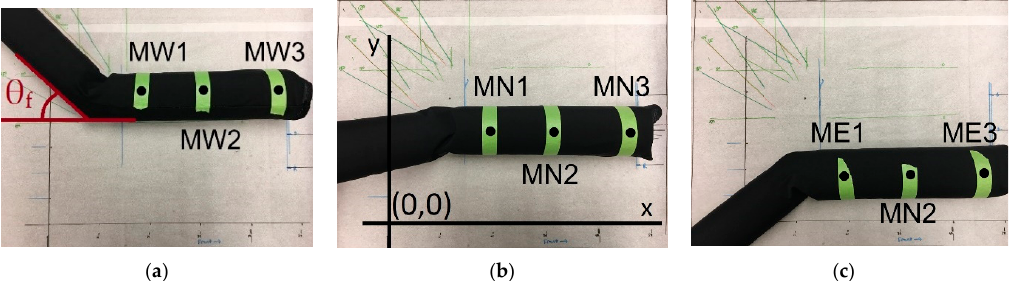
Figure 3. Sleeve sewn together on the arm and placed on plain background as captured by a fixed camera for ( a ) three MWs (Marker: West), ( b ) three MNs (Marker: North), and ( c ) three MEs (Marker: East). The sleeve shown here for demonstration is the stretchy sleeve. In addition, part ( a ) highlights the flexion angle ( θ f ) , and ( b ), the coordinate axes and origin.